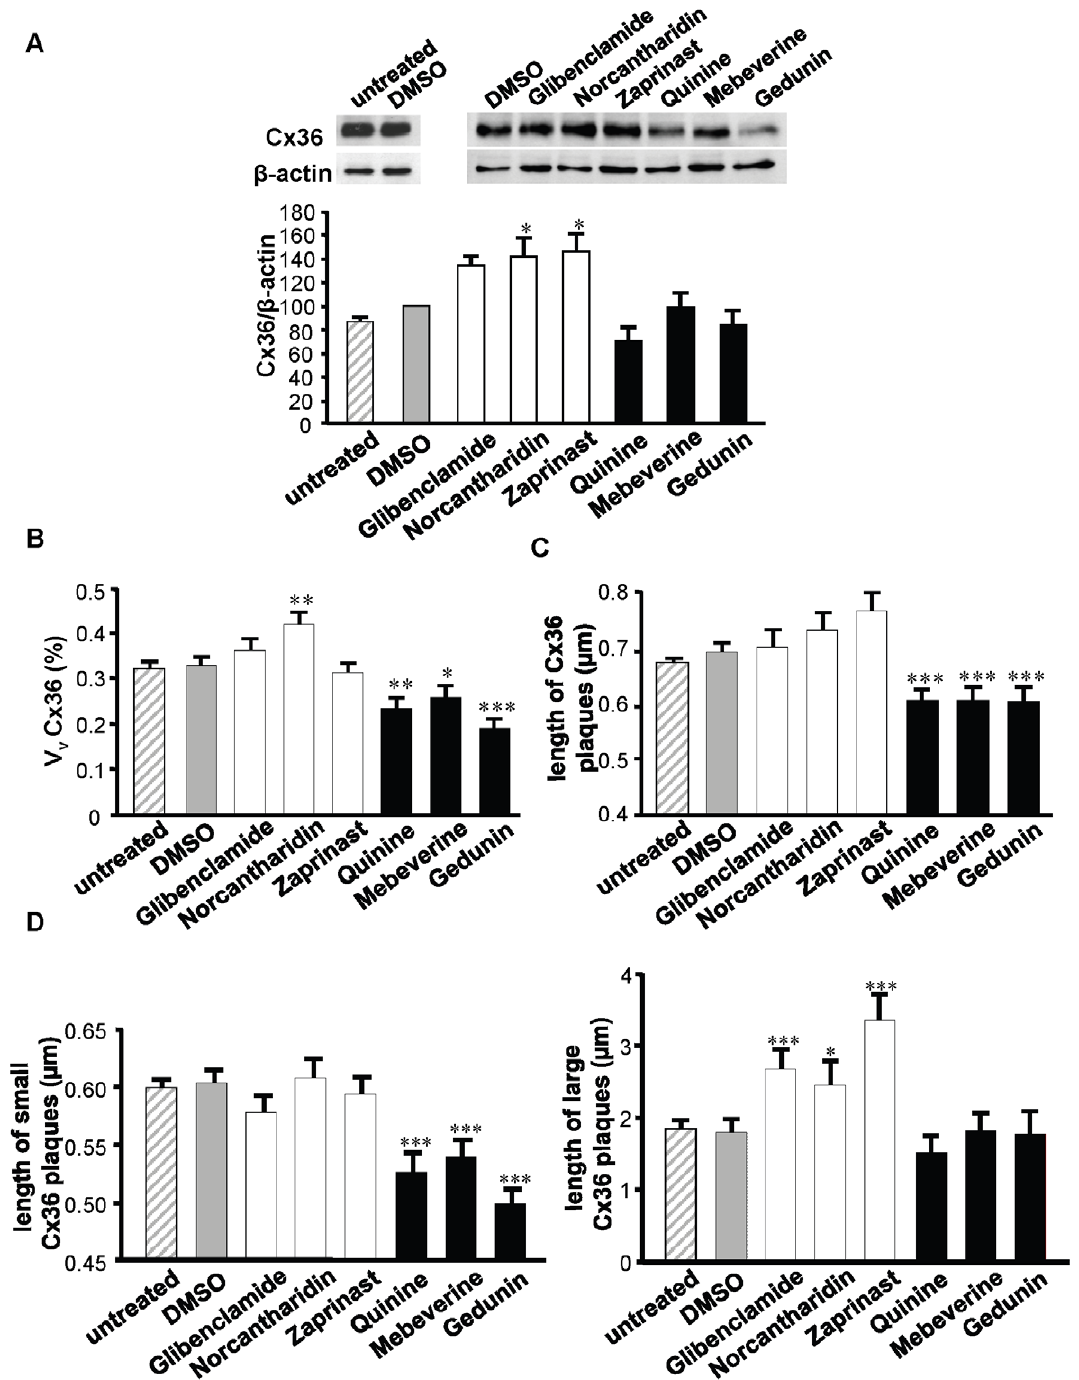
Figure 5. Molecules altering the synchrony index, modify Cx36 expression and the size of Cx36 plaques. ( A ) Immunolabeling of total protein extracts revealed that the steady state levels of Cx36 were increased in the MIN6 cells exposed to compounds enhancing the synchrony index, but unchanged in the MIN6 cells exposed to compounds reducing this index. 20 m g proteins were loaded per lane. The bars show means + SE ratio of the Cx36 to the b -actin signal, as evaluated by densitometric analysis of 5 independent experiments. *p , 0.05 versus DMSO-exposed controls; ( B ) The volume density (Vv) of Cx36 was increased by some of the drugs that enhanced MIN6 cell synchronization, and decreased by all the drugs decreasing this synchronization. Data show means + SE of three independent experiments. *p , 0.05; **p , 0.01; ***p , 0.001 versus DMSO-exposed controls; ( C ) The Vv changes were mostly accounted for by differential alterations in the length of Cx36 plaques, defined as the span of the longest chord through the object outline. Data show means + SE of three independent experiments. *p , 0.05; **p , 0.01; ***p , 0.001 versus DMSO-exposed controls; ( D ) The length of ‘‘small’’ Cx36 plaques was reduced in cells exposed to drugs decreasing the synchrony index ( left panel ), whereas that of ‘‘large’’ plaques increased in cells exposed to drugs enhancing this index ( right panel ). Data show means + SE of three independent experiments. *p , 0.05 and ***p , 0.001 versus DMSO-exposed controls. For all parameters, no difference was observed between untreated and DMSO-treated cells.